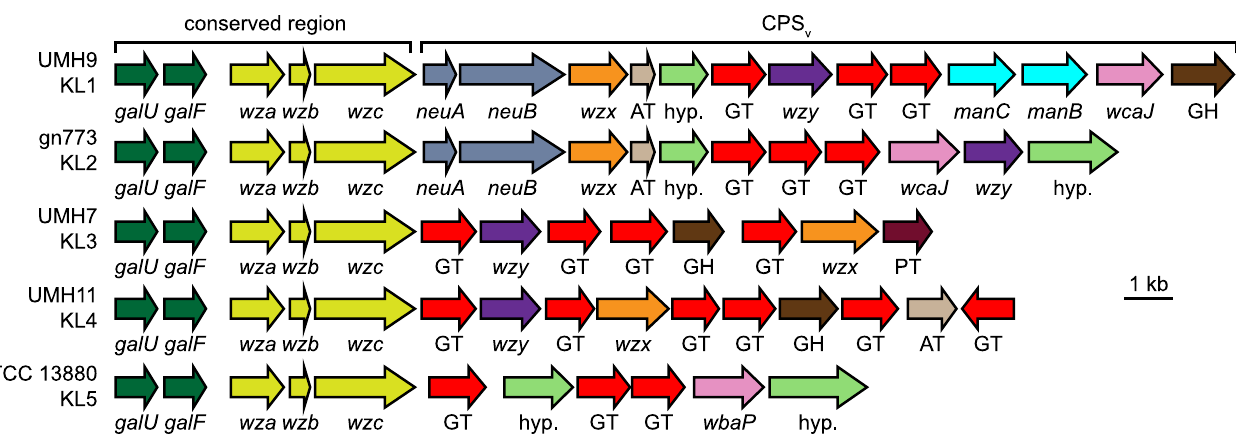
Fig 3. Annotation of KL from selected S . marcescens strains. KL were identified from the indicated genomes and annotated manually. Individual genes are represented by arrows and were colored according to predicted function. The conserved and variable (CPS v ) regions of each KL are indicated. Abbreviations: AT, acetyltransferase; GT, glycosyltransferase; GH, glycosylhydrolase; hyp. hypothetical protein of unknown function; PT, pyruvyltransferase.